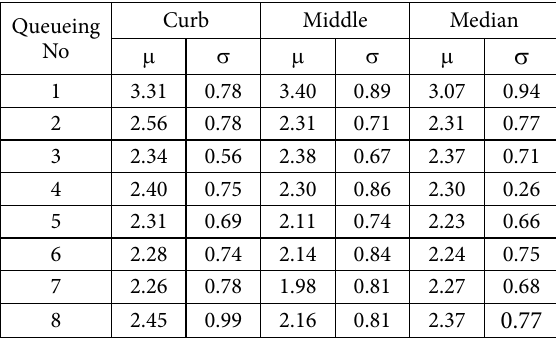
Table 2. Average and standard deviation of the headways of the queuing vehicles Curb Queueing No